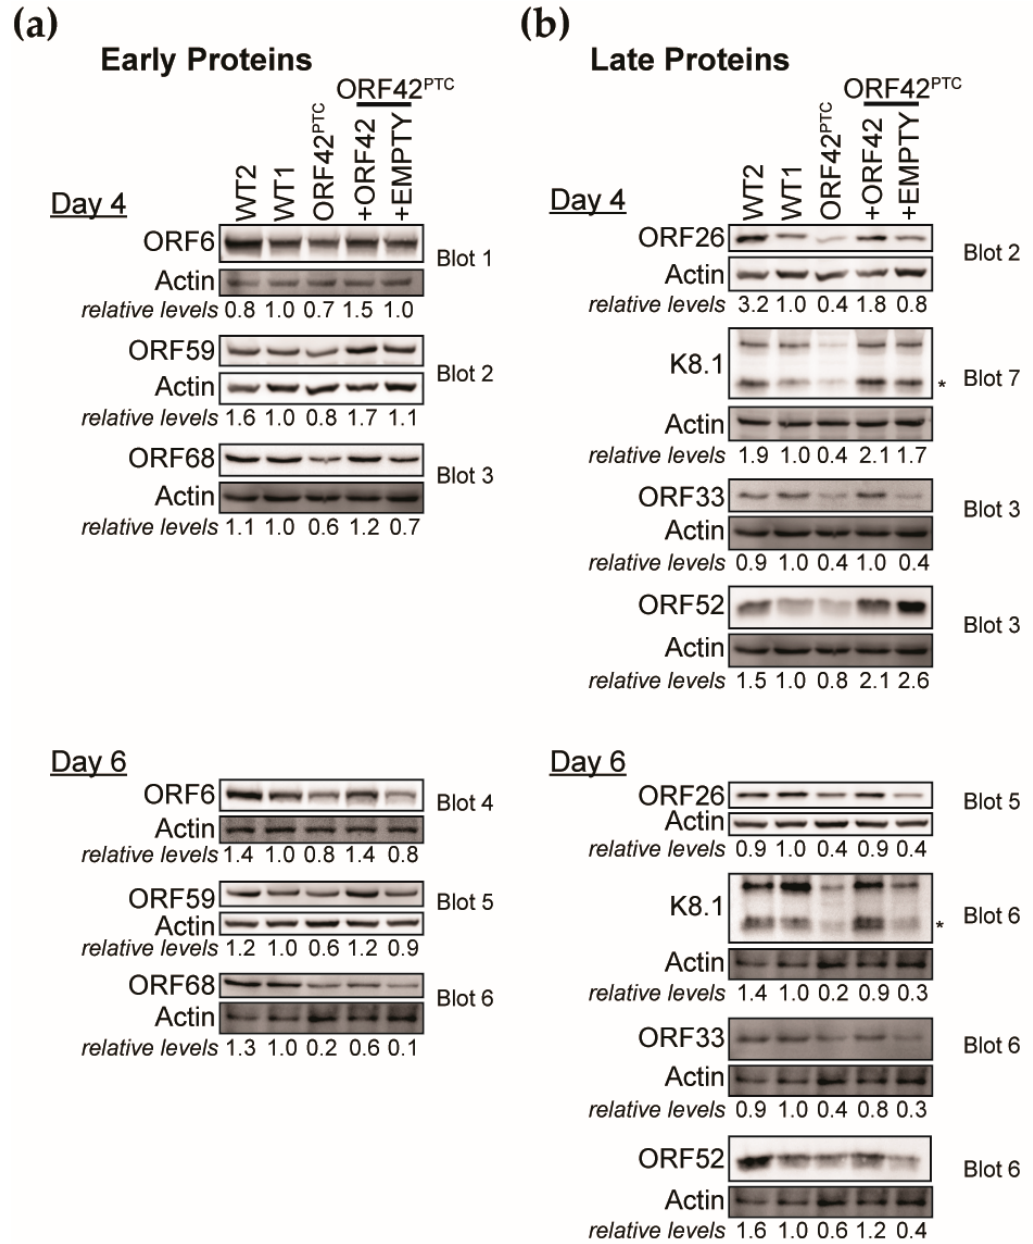
Figure 4. Loss of full-length ORF42 impairs the accumulation of viral proteins. The lytic cycle was induced in the KSHV-infected iSLK.RTA cells by addition of doxycycline (1 µ g / mL) to the media. Protein was collected four and six days post-induction. Western blotting was used to measure the levels of the indicated early ( a ) and late ( b ) viral proteins. Expression is reported normalized to actin and relative to the WT1 line for the blot shown. All blots shown are from the same biological replicate and are representative of at least 3 biological replicates. Table 2 includes the average and standard deviation values for all the replicates. Several proteins were measured on the same blot and normalized to the same actin blot, as indicated by the blot number. For the glycoprotein K8.1, we used the band corresponding to the size predicted from the sequence for quantification (marked by the asterisk). Other bands likely represent glycosylated forms of K8.1.